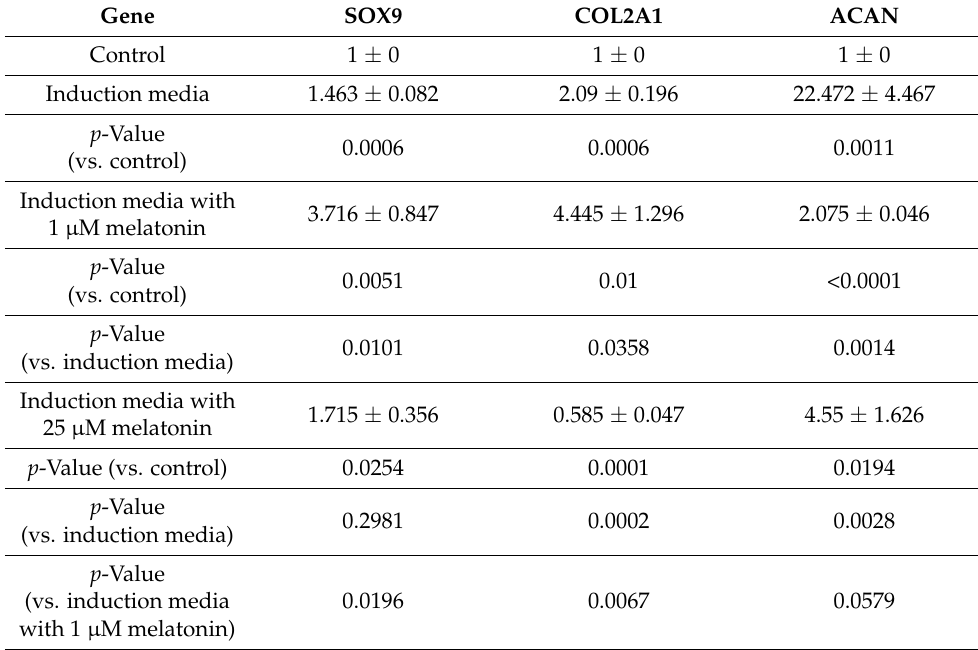
Table 7. Relative gene expression of chondrogenesis-related